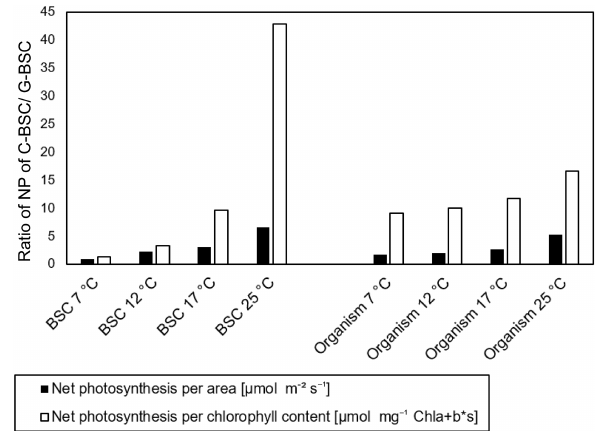
Figure 6. Difference in the ratio of net photosynthesis based on ei- ther area or chlorophyll content between C-BSC dom and G-BSC dom (organism) and also between C-BSC all and G-BSC all , (BSC) mea- sured at different temperatures. NP = net